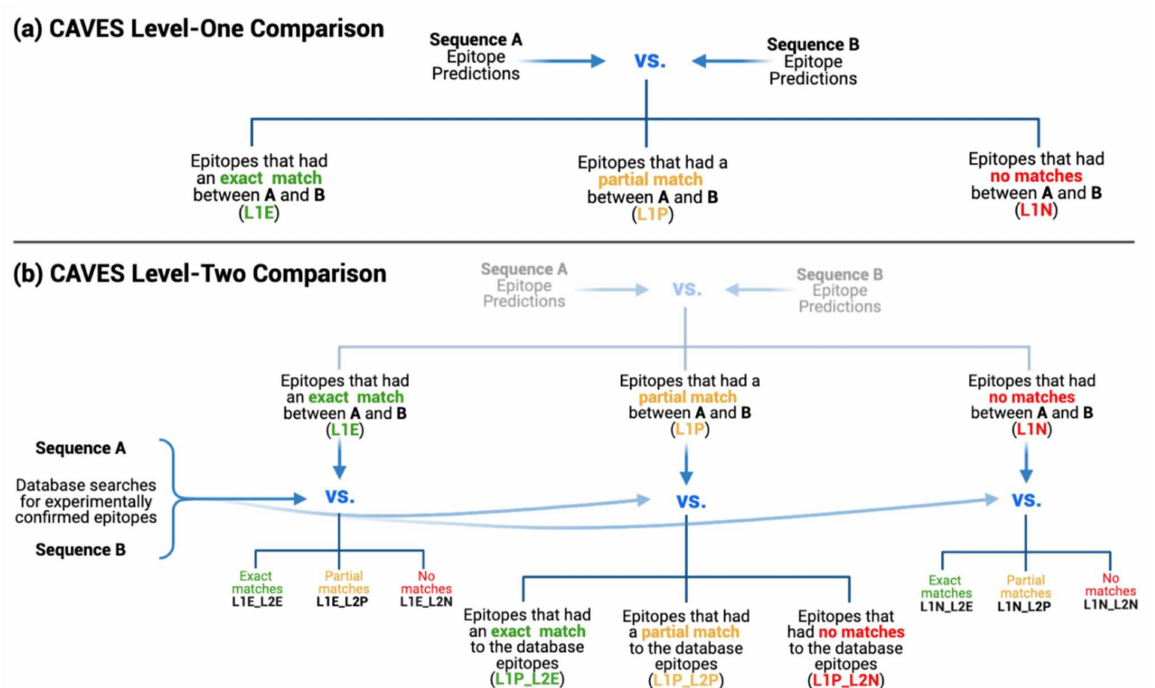
Figure 4. CAVES two-level comparison approach. ( a ) CAVES Level-One (L1) compares two files of epitope predictions, sorting them into categories of exact matches (L1E), partial matches (L1P), and novel epitopes (L1N). ( b ) CAVES Level-Two (L2) compares the epitopes from the three resulting L1 categories to files of database search results, sorting each L1 category into an additional triplet of exact (L2E), partial (L2P), and novel (L2N)